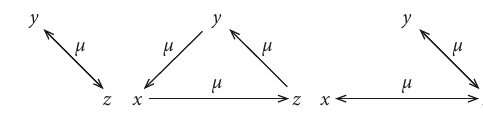
Figure 2: Three representative mutations in RPS. Table 2: Hopf curve of different mutant